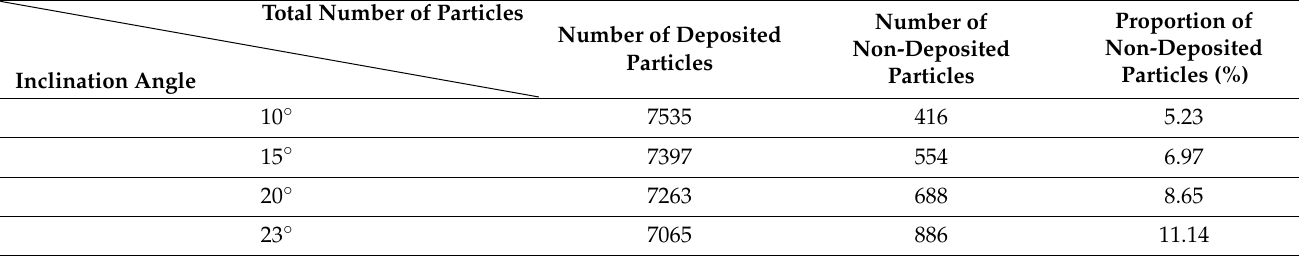
Table 4. Simulation result of dust deposition for 3.5 days at different inclination angles.